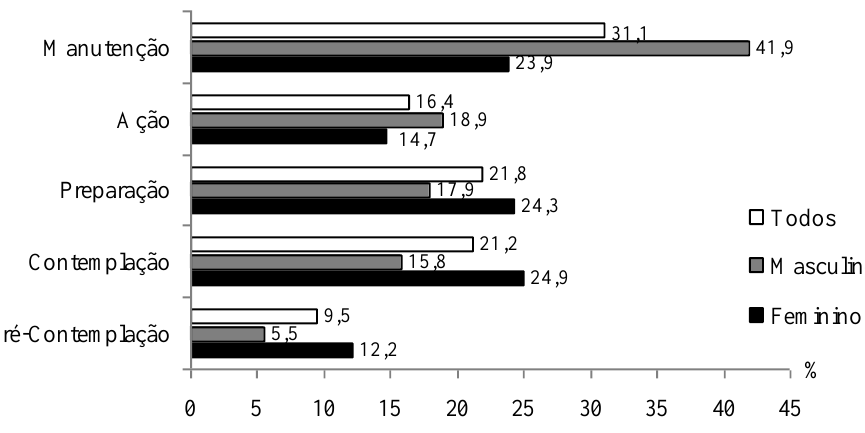
Figura 1- Distribuição relativa (%) por estágios de mudança de comportamento para atividade física por sexo (feminino e masculino) e para todos os adolescentes estudantes do ensino médio no estado de Pernambuco,